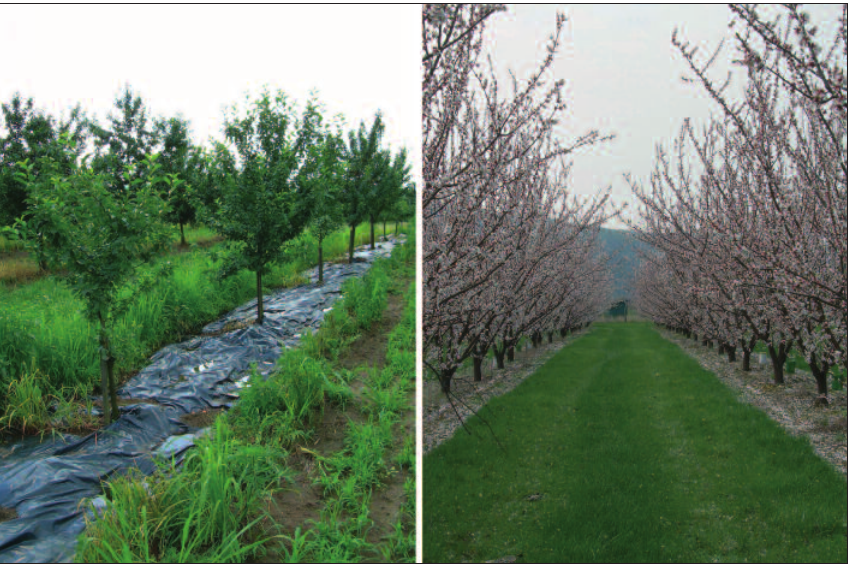
Figures 3. and 4.: Use of black foil in sour cherry plantation (Újfehértó) (left) (P. T. Nagy) Grass between rows in an apricot plantation (Boldogkôváralja) (right) (P. T.